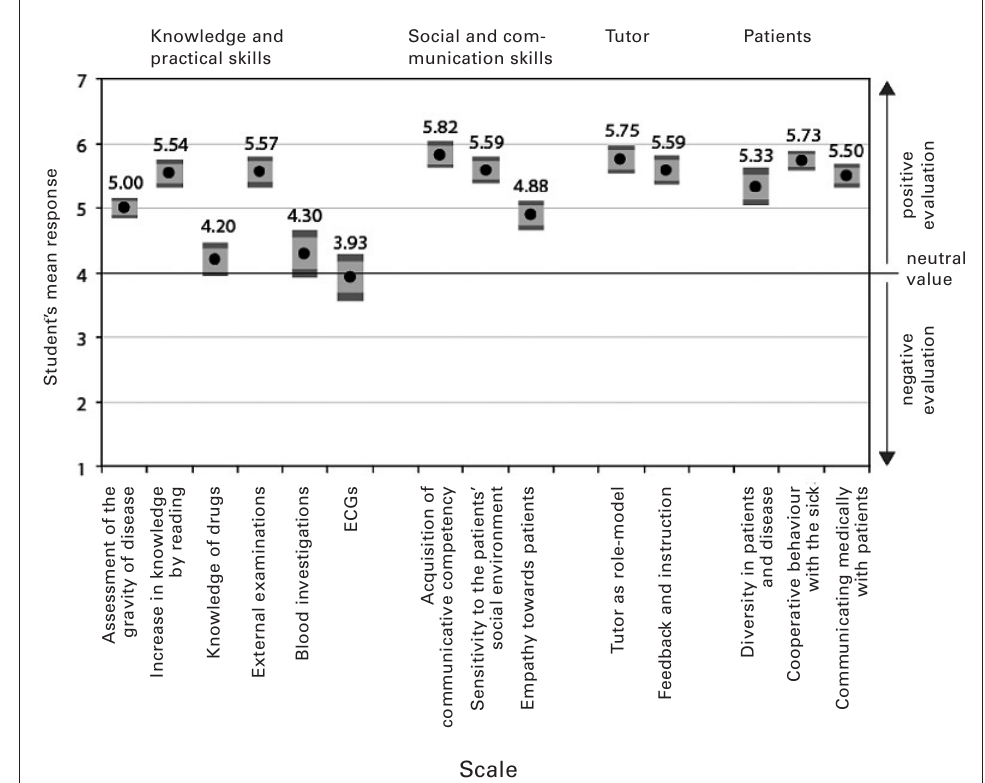
Figure 1 Responses on all scales com- prised over all content areas. dis- played are mean values obtained from averaging all responses from each of the two academic years (black dots).The grey shaded area around the neutral scale value of 4 indicates the 95% confidence interval of the mean (light grey area), and the 99% confidence interval respectively (dark grey area).